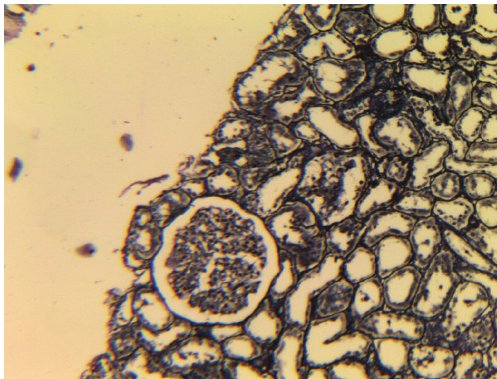
Figure 2: MPGN with mesangial cell proliferation, an increase in mesangial matrix (black staining in silver stain) and basement membrane thickening and tram track appearance in silver